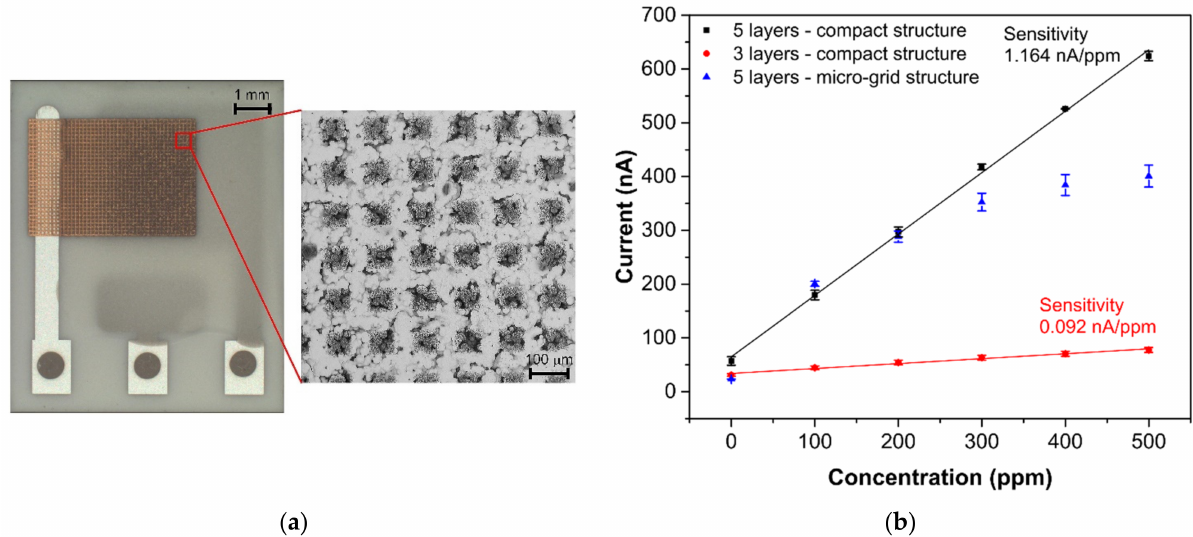
Figure 6. ( a ) Sensor with semi-planar topology and gold “micro-grid” electrode, ( b ) Calibration curves of sensors with semi-planar electrode topology and different gold working electrode structures (each point represents a mean value of 3 repeated exposures with corresponding 95% confidence interval). Conditions: 22 ◦ C, 40%RH, 101.325 kPa, 1